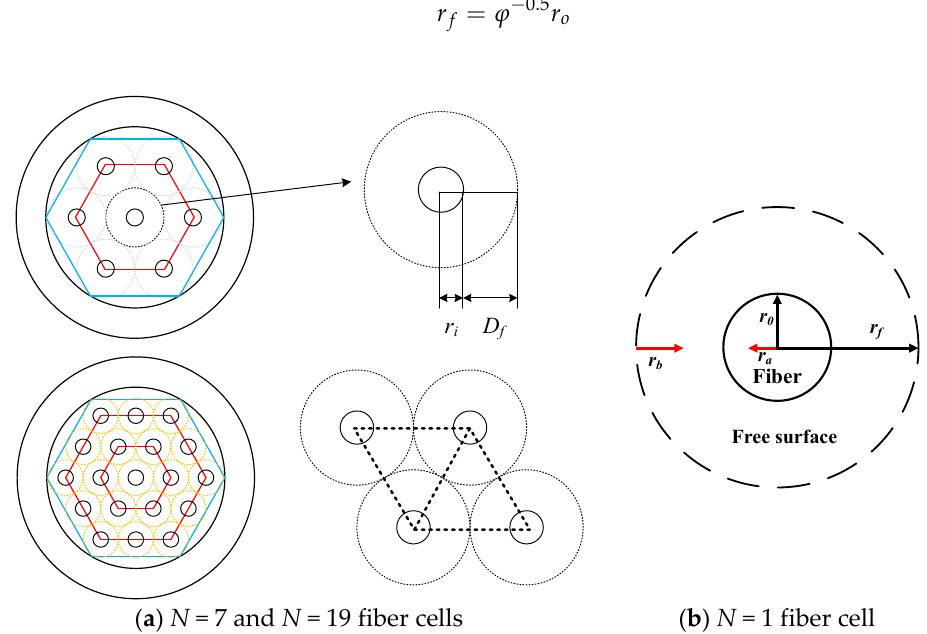
Figure 1. A scheme for the Happel’s free surface model with various fiber cells.